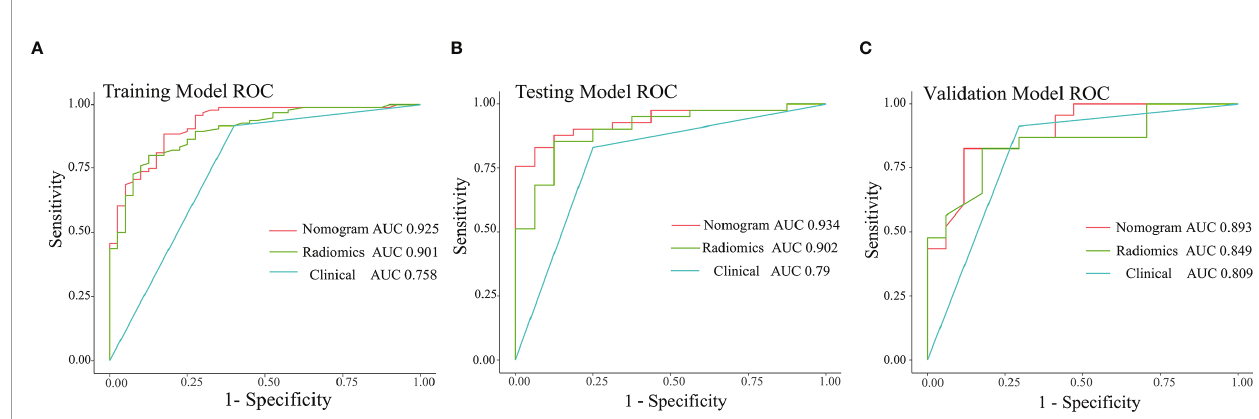
FIGURE 8 | ROC curves of the three models in the training (A) , testing (B) , and independent validation (C) cohort.